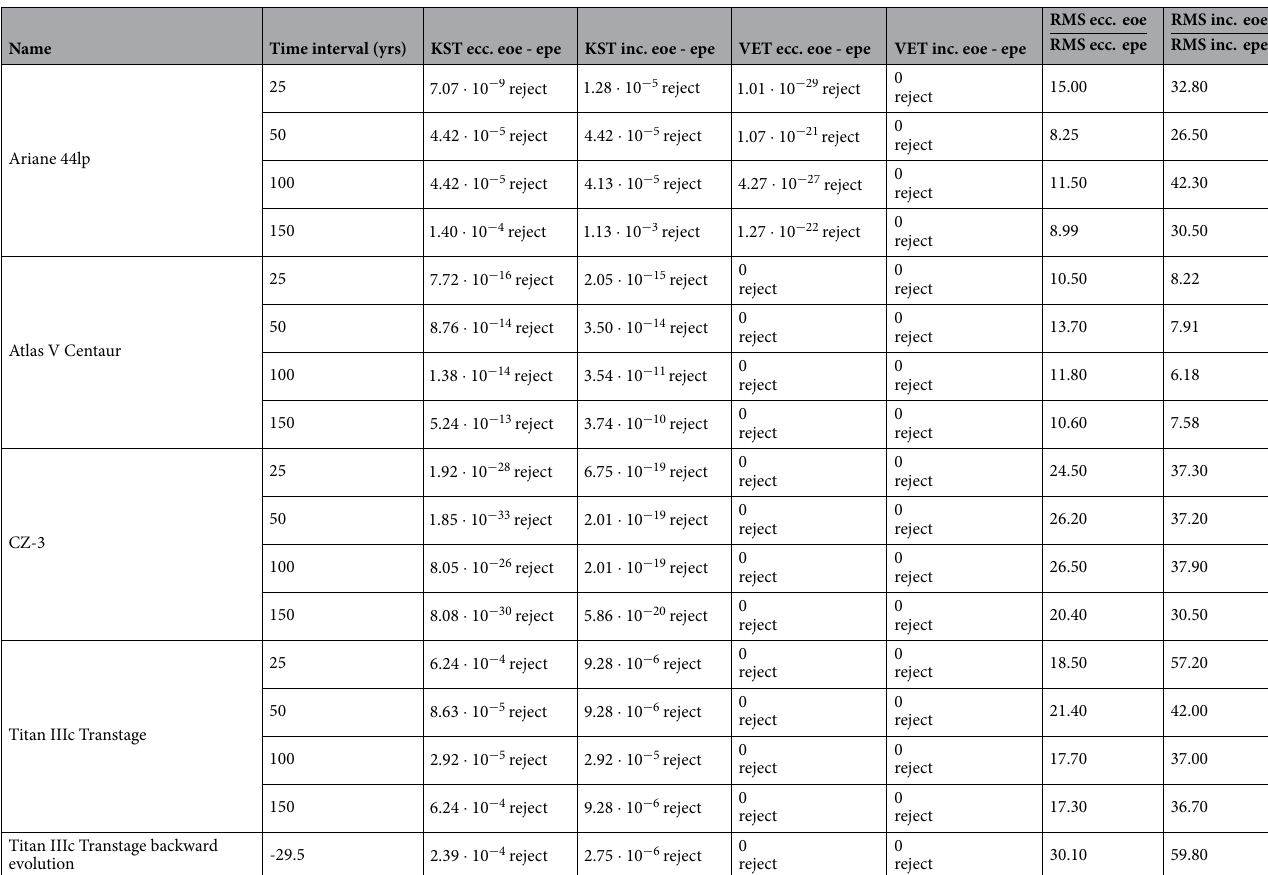
Table 2. The p-value of the Kolmogorov-Smirnov test and Variance Equivalence test for the errors between osculating (eoe) and proper elements (epe) at different final times (25, 50, 100, and 150 years). The last two columns contain the ratio of the root mean square (RMS) between the osculating errors and the proper elements errors. The last row refers to an example where we back-propagate in time. A 0 p-value means a number lower than 10 −40